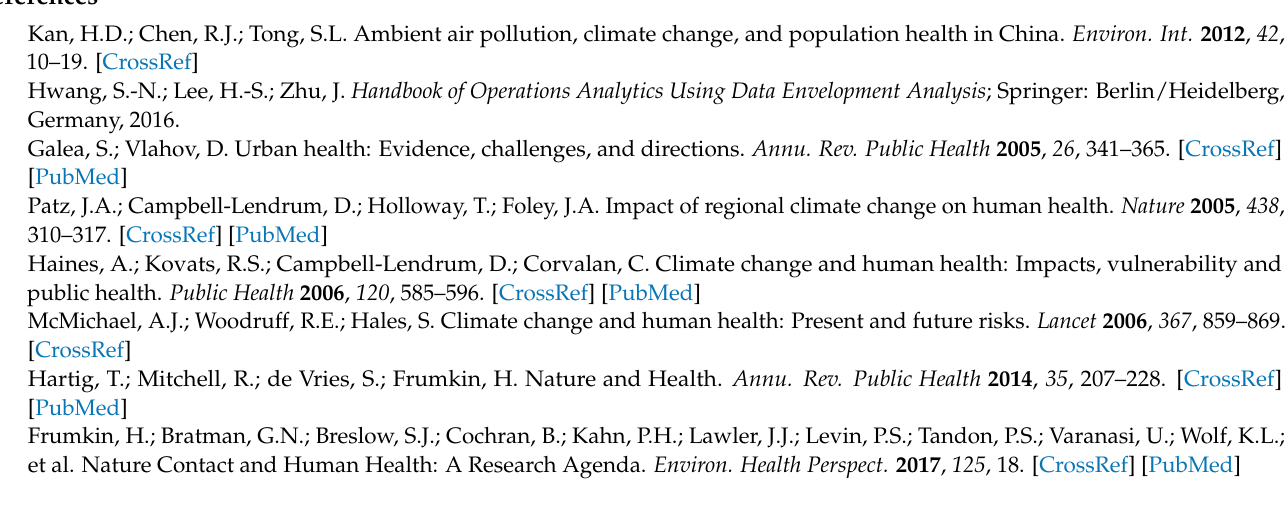
ture forecasting VTH), Table S2: Sample learning and prediction accuracy comparison (temperature forecasting OWT (100 million), Table S3: Sample learning and prediction accuracy comparison (temperature forecasting NOH (10,000 people), Table S4: Sample learning and prediction accuracy comparison (humidity forecasting VTH), Table S5: Sample learning and prediction accuracy compari- son (humidity forecasting OWT (100 million), Table S6: Sample learning and prediction accuracy comparison (humidity forecasting NOH (10,000 people)), Table S7: Sample learning and prediction accuracy comparison (precipitation forecasting VTH), Table S8: Sample learning and prediction accuracy comparison (precipitation forecasting OWT (100 million), Table S9: Sample learning and prediction accuracy comparison (precipitation forecasting NOH (10,000 people)), Table S10: Sample learning and prediction accuracy comparison (sunshine forecasting VTH), Table S11: Sample learning and prediction accuracy comparison (sunshine forecasting OWT (100 million), Table S12: Sample learning and prediction accuracy comparison (sunshine forecasting NOH (10,000 people)), Table S13: Sample learning and prediction accuracy comparison (four indicators forecasting VTH), Table S14: Sample learning and prediction accuracy comparison (four indicators forecasting OWT (100 million)), Table S15: Sample learning and prediction accuracy comparison (four indicators forecasting NOH: 10,000